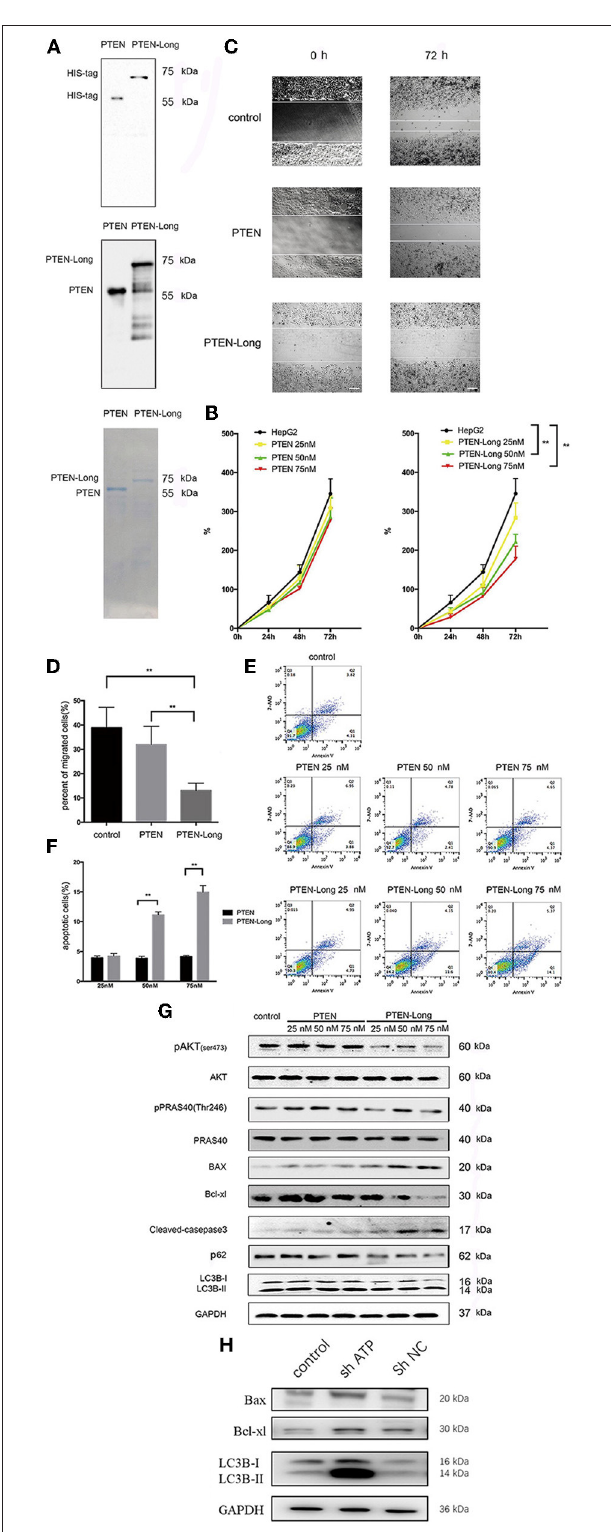
FIGURE 6 | Purified PTEN-Long induces autophagy and apoptosis of HepG2 cells. (A) Western blot analysis of purified protein PTEN isoforms. (B)